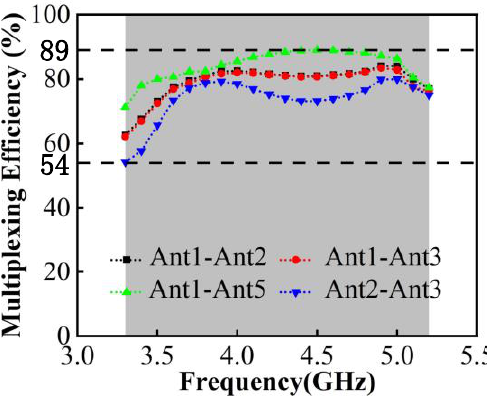
Figure 18. Calculated Multiplexing efficiency.